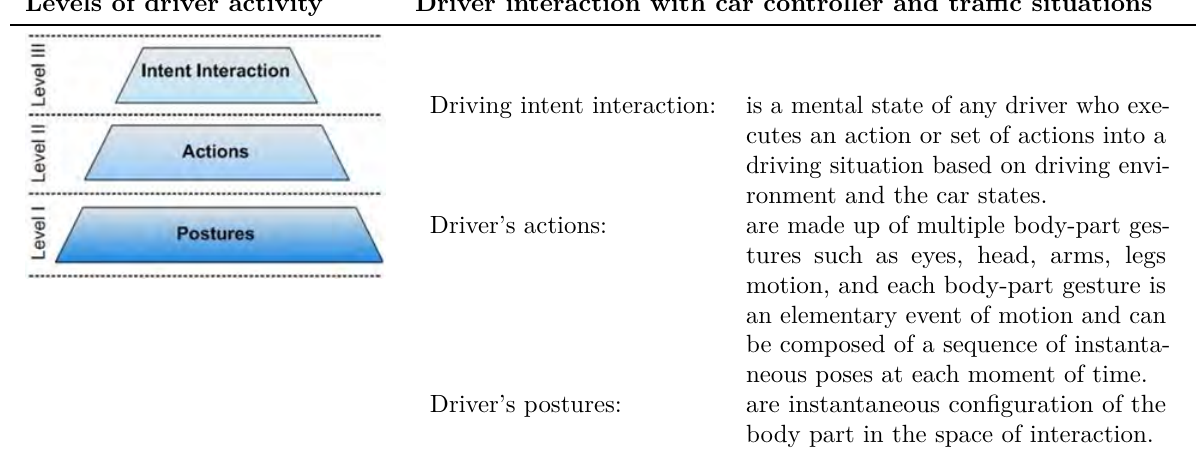
Table 1. Hierarchy of driver